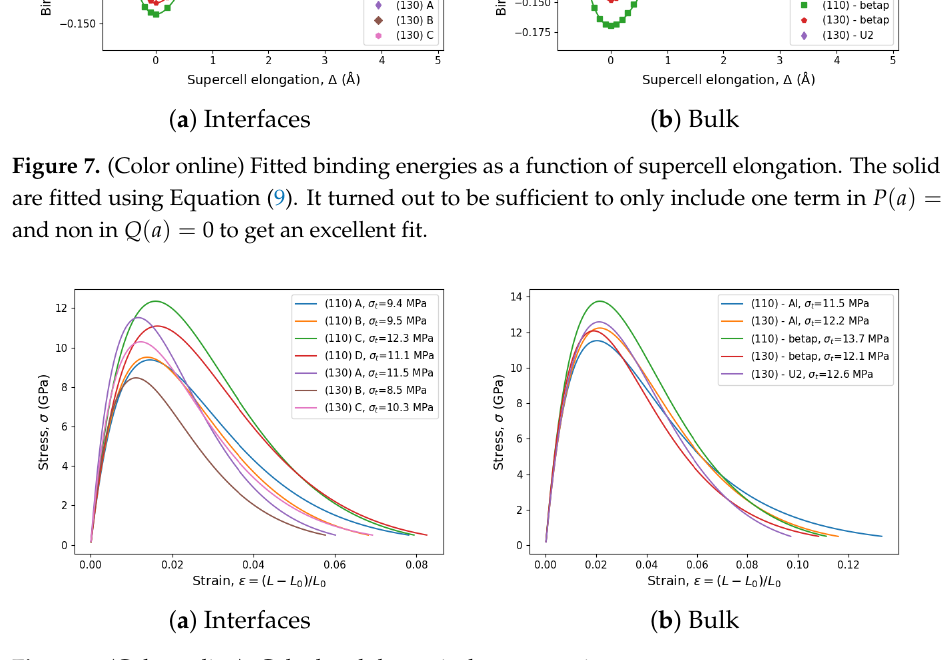
Figure 8. (Color online). Calculated theoretical stress–strain